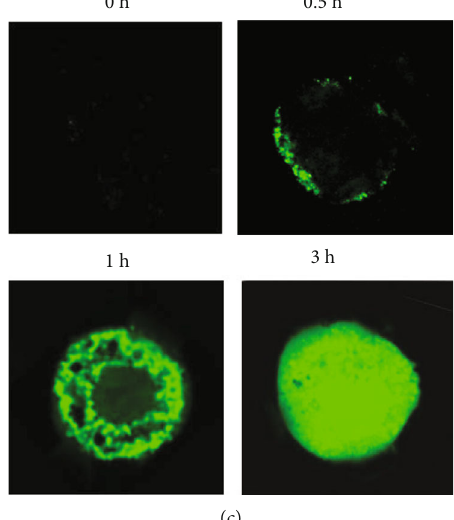
Figure 1: Arsenic-induced ROS formation in primary cultured mouse hepatocytes using DCF-DA. The results are expressed as mean ± SD independent experiments of 6 independent experiments. (a) Time-dependent arsenic (10 μ M)-induced ROS in the hepatocytes was quanti fi ed as relative fl uorescence intensity using multiplate reader. ∗ p < 0 : 01 vs. control and ∗∗ p < 0 : 001 vs. control. (b) The histogram represented ROS level produced by mouse hepatocytes in fl ow cytometry analysis with or without arsenic (10 μ M) treatment at di ff erent time points. (c) Microscopically, intracellular ROS was evaluated at di ff erent time periods after staining with DCF-DA using confocal microscope. The representative fi gure showed that at 30min of arsenic treatment, ROS generation was started from the peripheral region of a mouse hepatocyte and gradually progressed to the center of the cell with progression of time (40x magni fi cations). The fi gure is representative photomicrograph of 3 independent